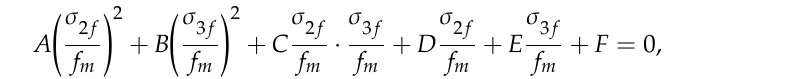
Figure 8. Comparison between Equation (1) and experimental results.